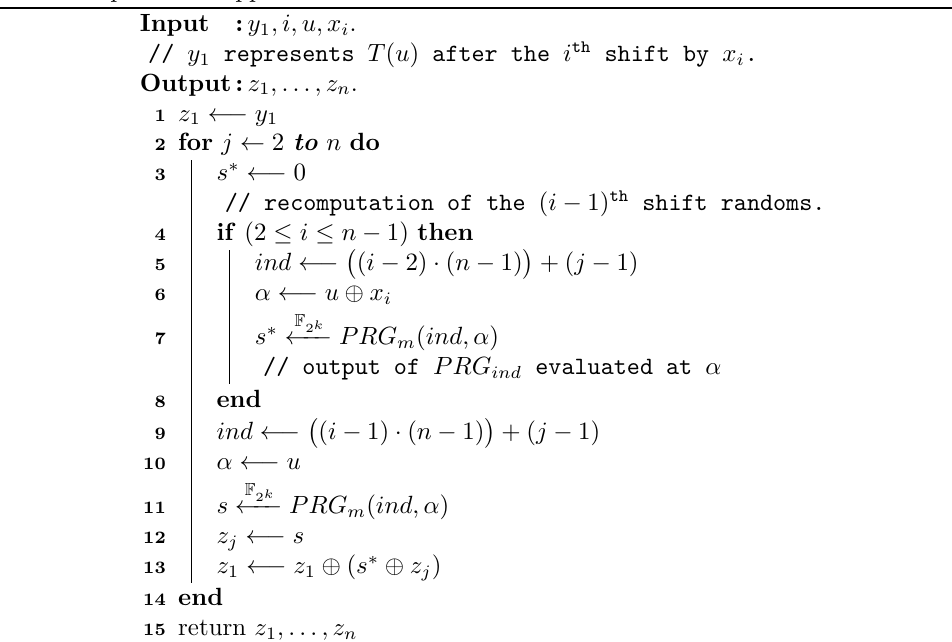
Algorithm 6: LR-n-m : LR procedure for normal variant using the multiple PRGs